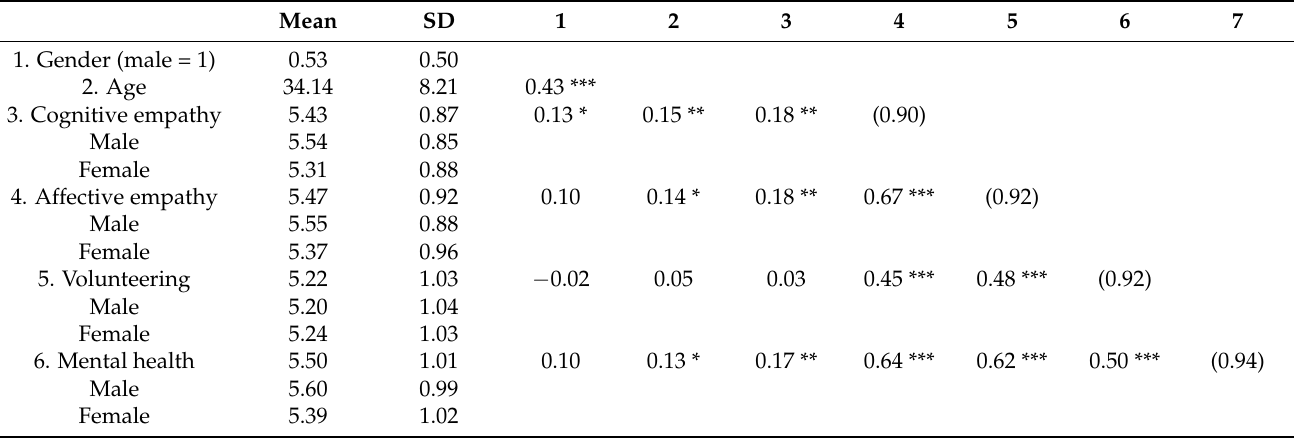
Table 1. Means, standard deviations, and zero-order correlations ( n = 301).